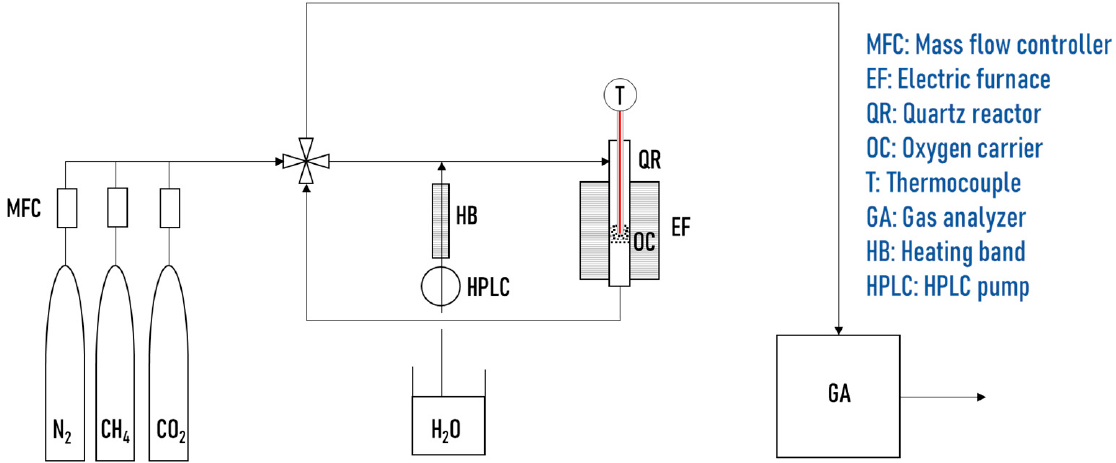
Figure 1. Experimental set-up for fixed-bed reaction tests.